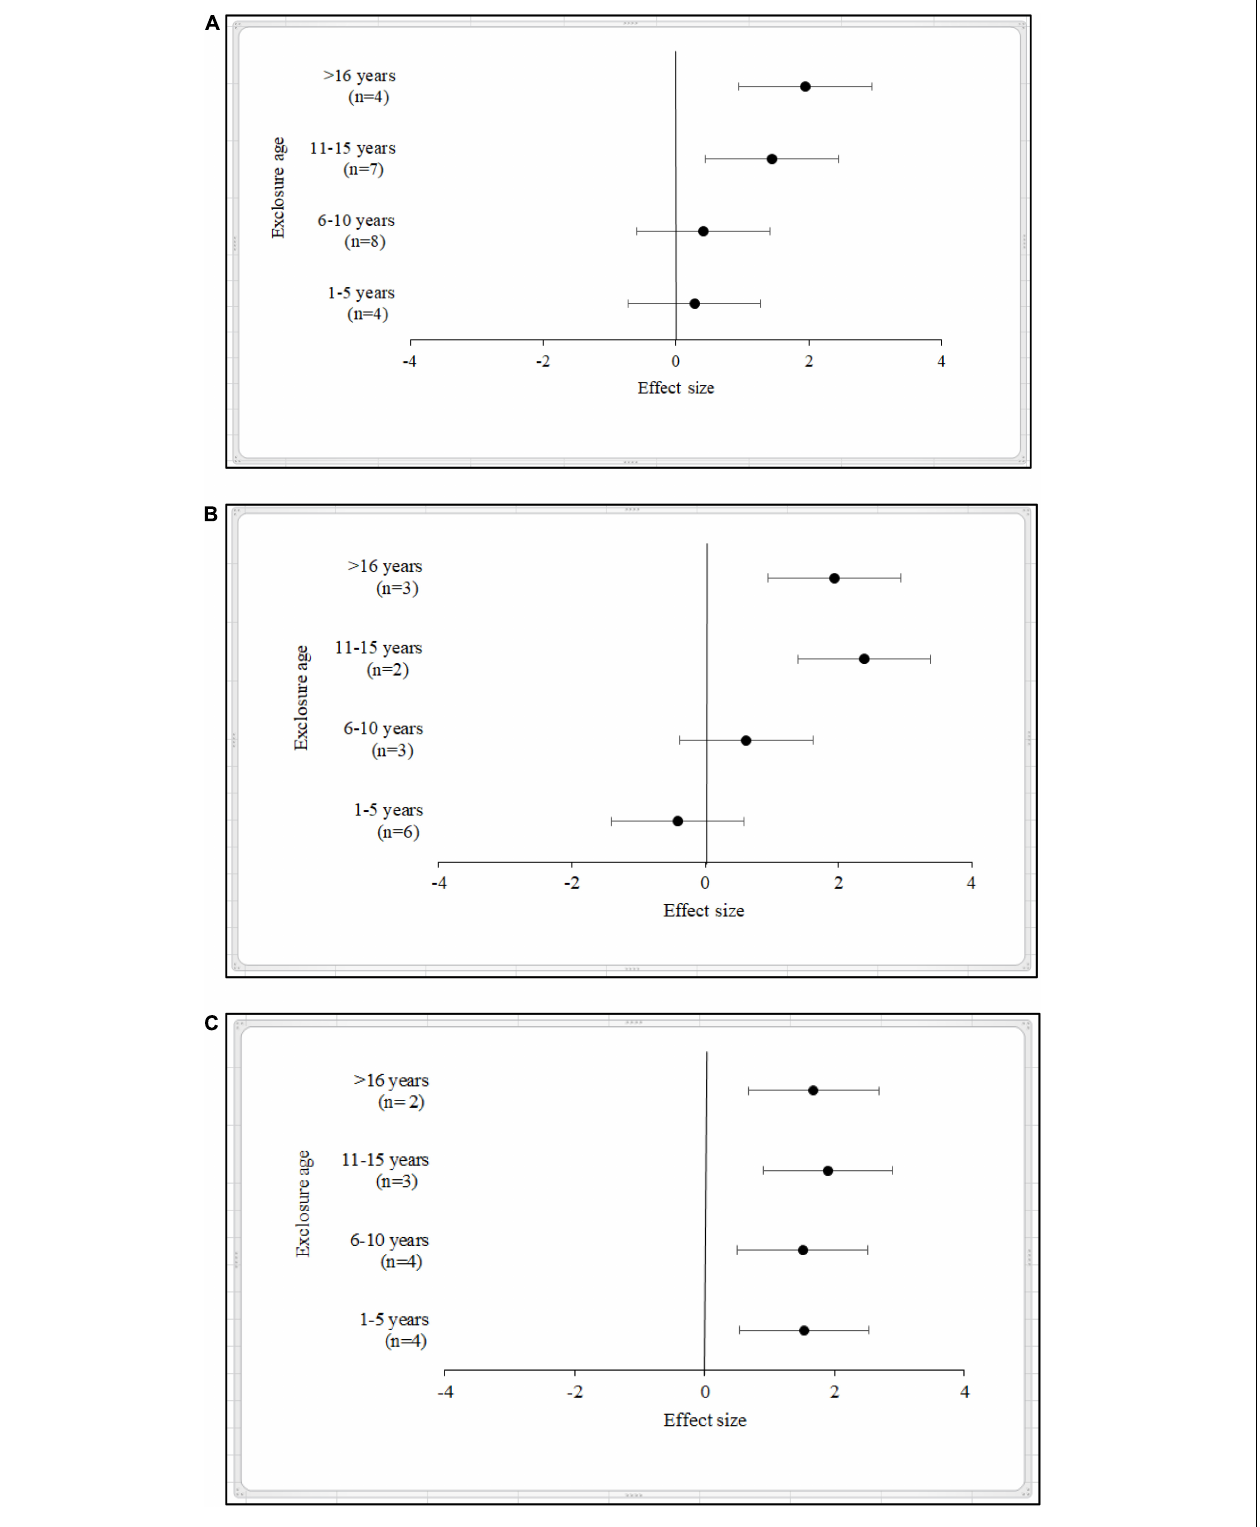
FIGURE 5 | Changes in soil organic carbon following establishment of exclosures on communal grazing lands in Ethiopia: (A) Cambisols, (B) Luvisols, and (C) Leptosols. Values are effect sizes with 95% confidence intervals (CI). A significant response is when the CI does not overlap with zero. The number of observations in each age category is shown in